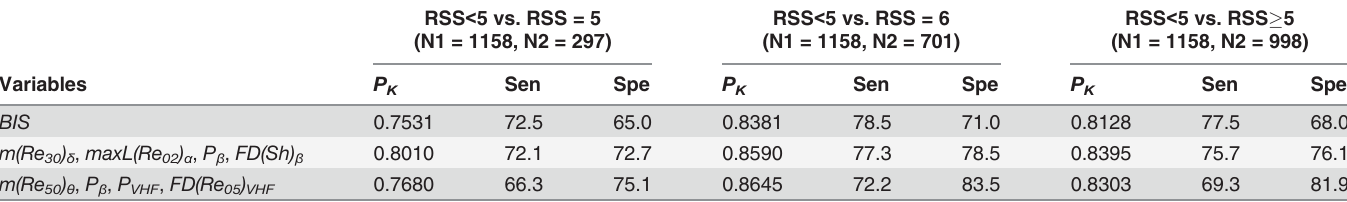
Table 4. RSS assessment: trial 3, trial 4 and trial 5.